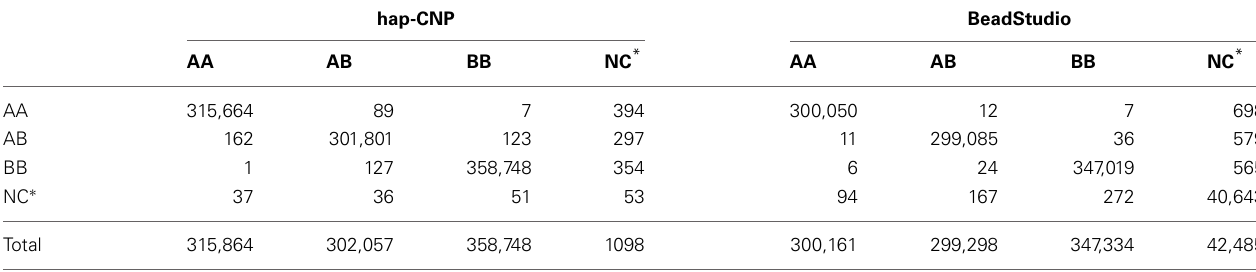
Table 6 | Concordance of normal genotypes between duplicated